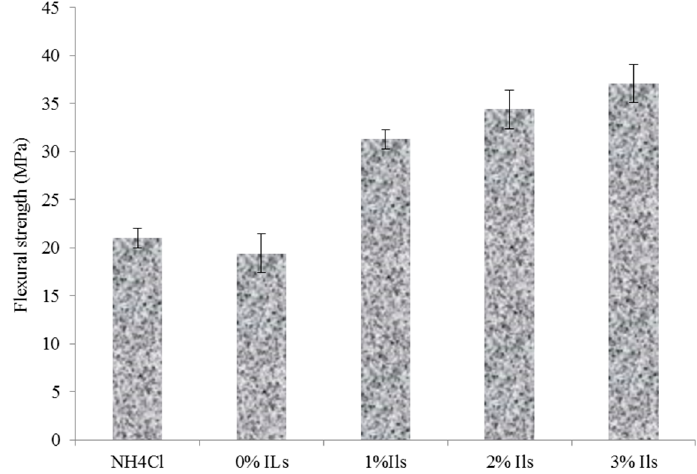
Figure 10. Flexural Strength of the manufactured panels made from synthesized resins.